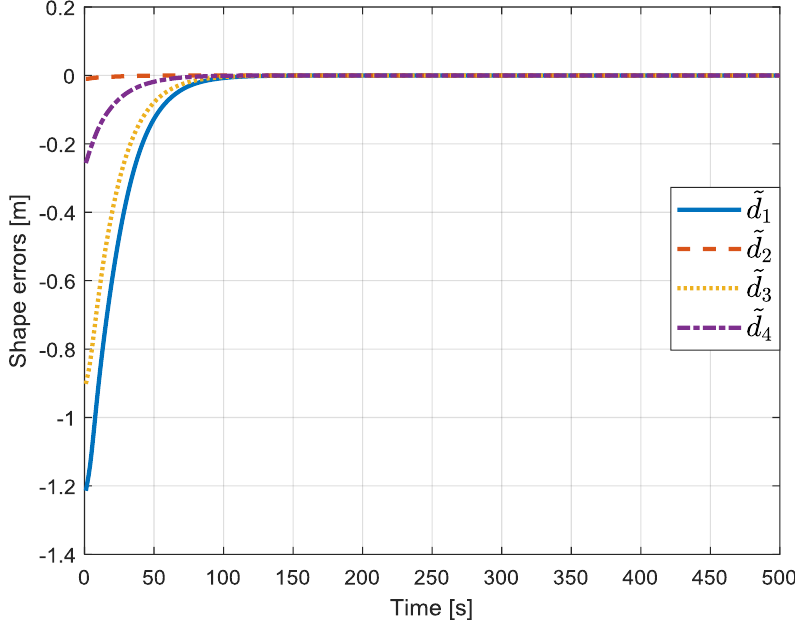
Figure 10. Errors in the posture of the